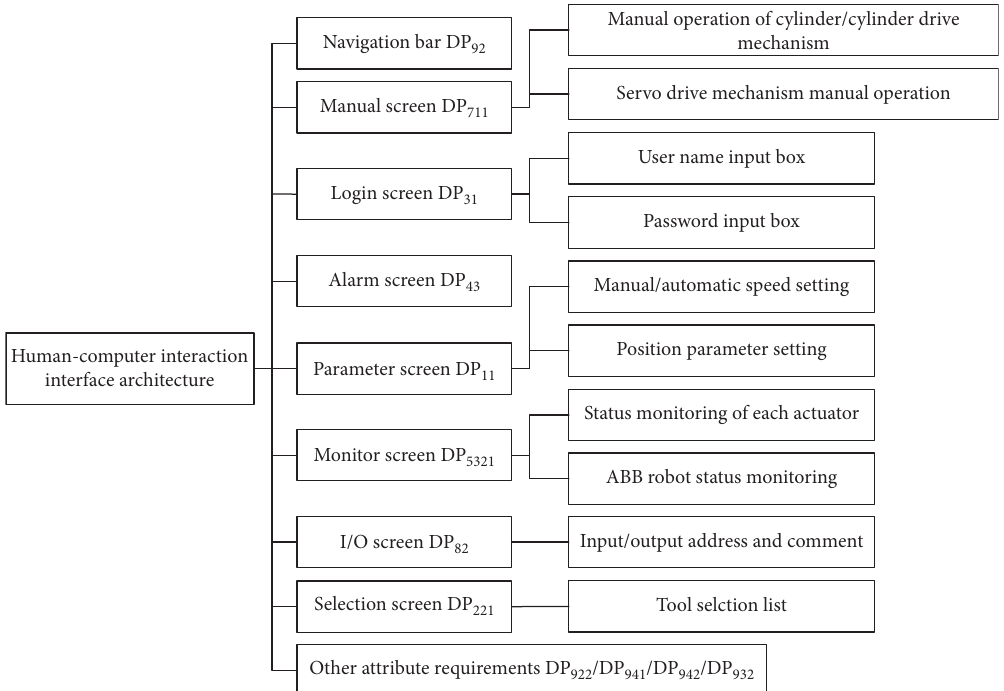
Figure 13: The human-machine interface of the control service